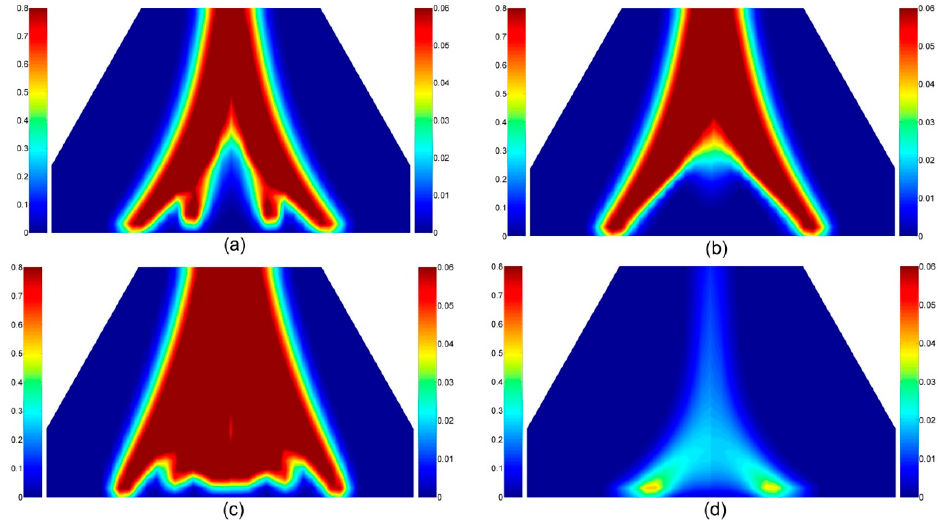
Figure 6. The mass fractions of CO 2 (left hand side) and CO (right hand side) in the gas phase for 10 mm thickness PMMA under 75 kW/m 2 heat flux at: ( a ) 100 s; ( b ) 200 s; ( c ) 300 s; and ( d ) 400 s. 11